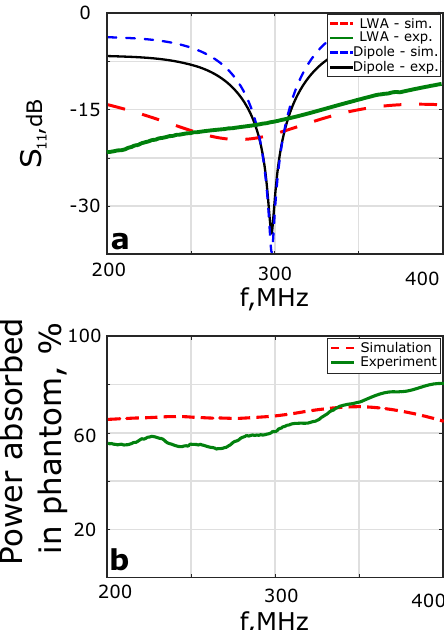
Fig. 5 Simulated and measured properties of the optimized LWA and the reference dipole antenna. a S 11 radiated into and absorbed by the